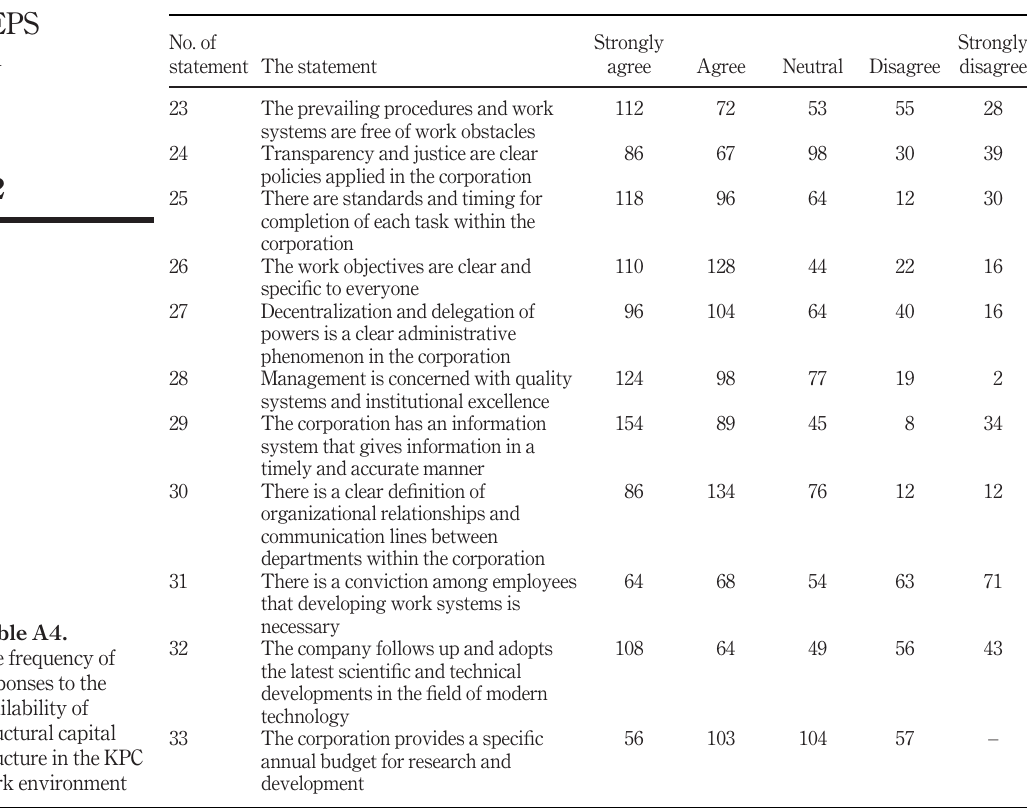
Table A4. The frequency of responses to the availability of structural capital structure in the KPC work